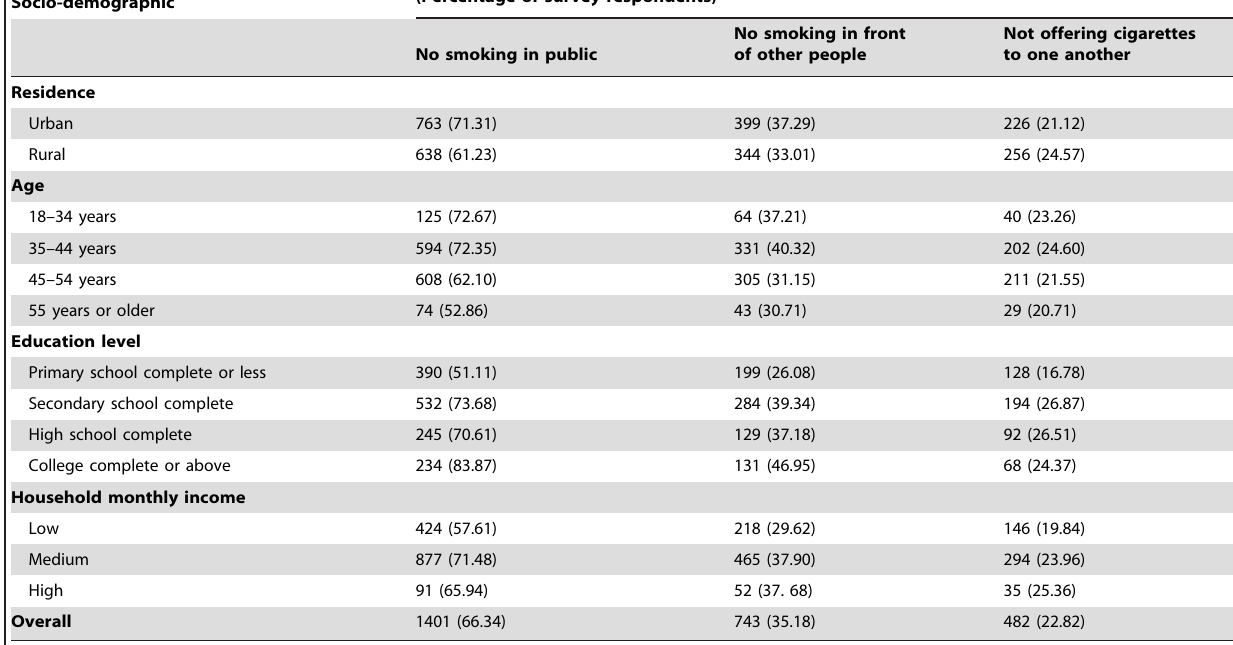
Table 4. Anti-tobacco messages which respondents got from mass media (past year).